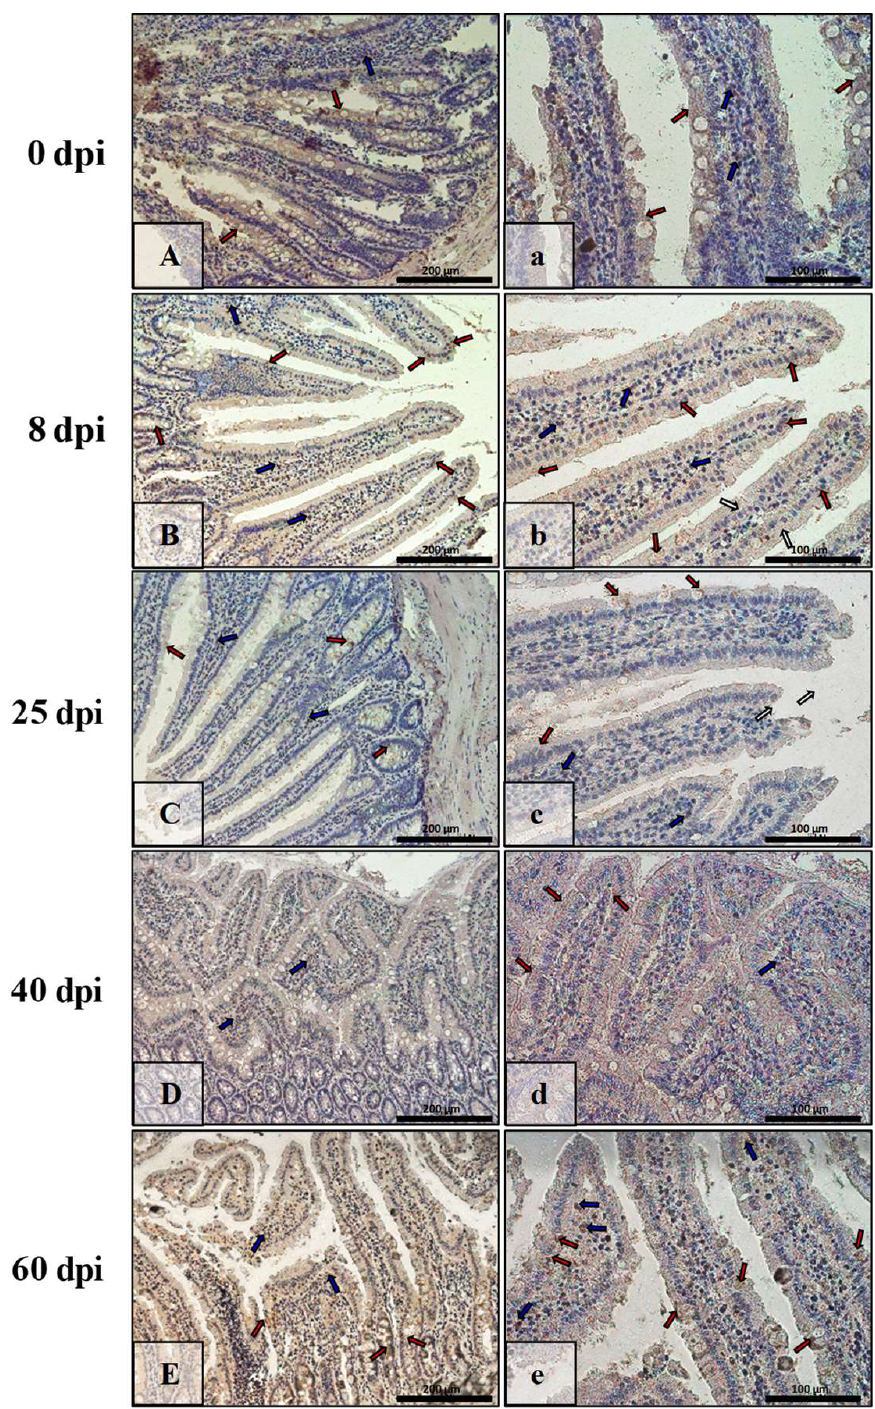
Figure 9. Representative microphotographs showing Bcl-2 immunoexpression in the small intestine of control animals ( A , a ) and on consecutive days ( B , b , C , c , D , d , E , e ) after H. diminuta infection. Positive IHC reaction—brown reaction marked with arrows: red—epithelial cells of the villi and intestinal crypts, blue and white—cells in the connective tissue lining of the mucosa. Lens magnification: × 20 ( A – E , scale bar: 200 µ m), × 40 ( a – e , scale bar: 100 µ m). The highest Bcl-2 immunoexpression was observed in the large intestine of the control animals (Figure 10A,a), primarily in the epithelial (cup) cells of intestinal crypts (red arrows), whereas in the lamina propria of the mucosa, Bcl-2-positive cells (blue